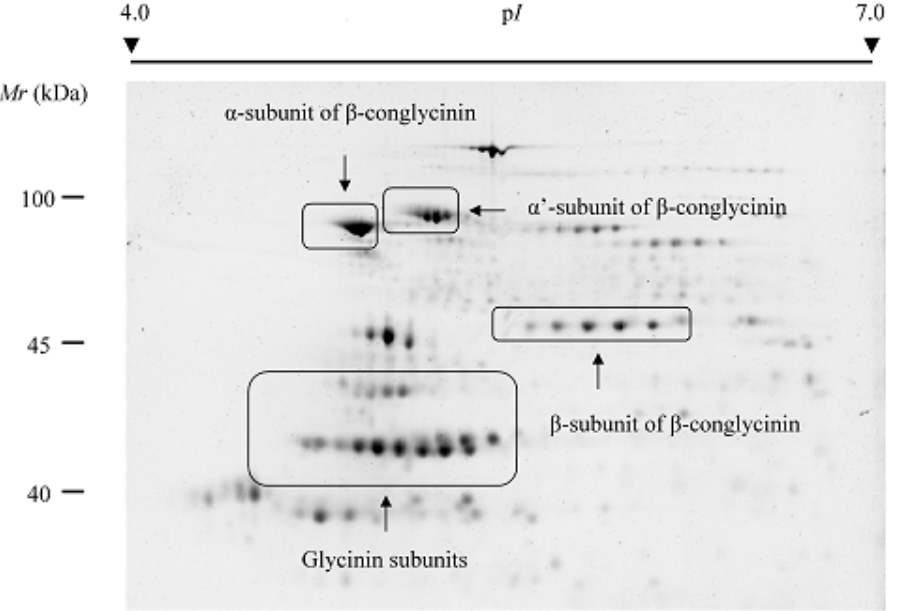
Figure 1. Standard ( a ) and targeted ( b ) 2 ‐ DE gel images of phaseolin (above) and patatin (below) isoforms from common bean ( P. vulgaris ) seeds and potato ( S. tuberosum ) tubers. Standard 2 ‐ DE gels were obtained from 250 μ g of total seed protein or total tuber protein extracts loaded into 24 ‐ cm ‐ long IPG strips of linear pH gradient 4–7 in the first dimension. The second dimension (SDS ‐ PAGE) was run on 12% ( w / v ) SDS ‐ PAGE gels. Gels were subsequently stained with SYPRO Ruby fluorescent stain. Targeted 2 ‐ DE gel images for high ‐ resolution profiles were obtained under the same conditions but using only 75 μ g of total protein extracts.